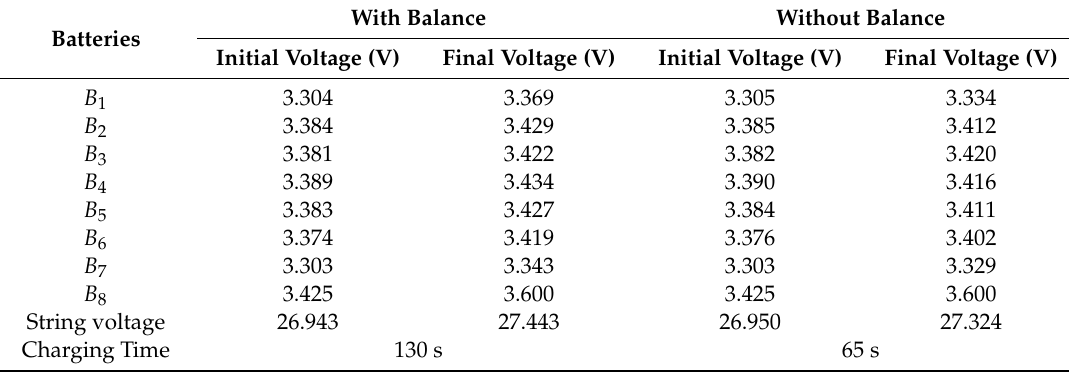
Table 6. Comparison with existing